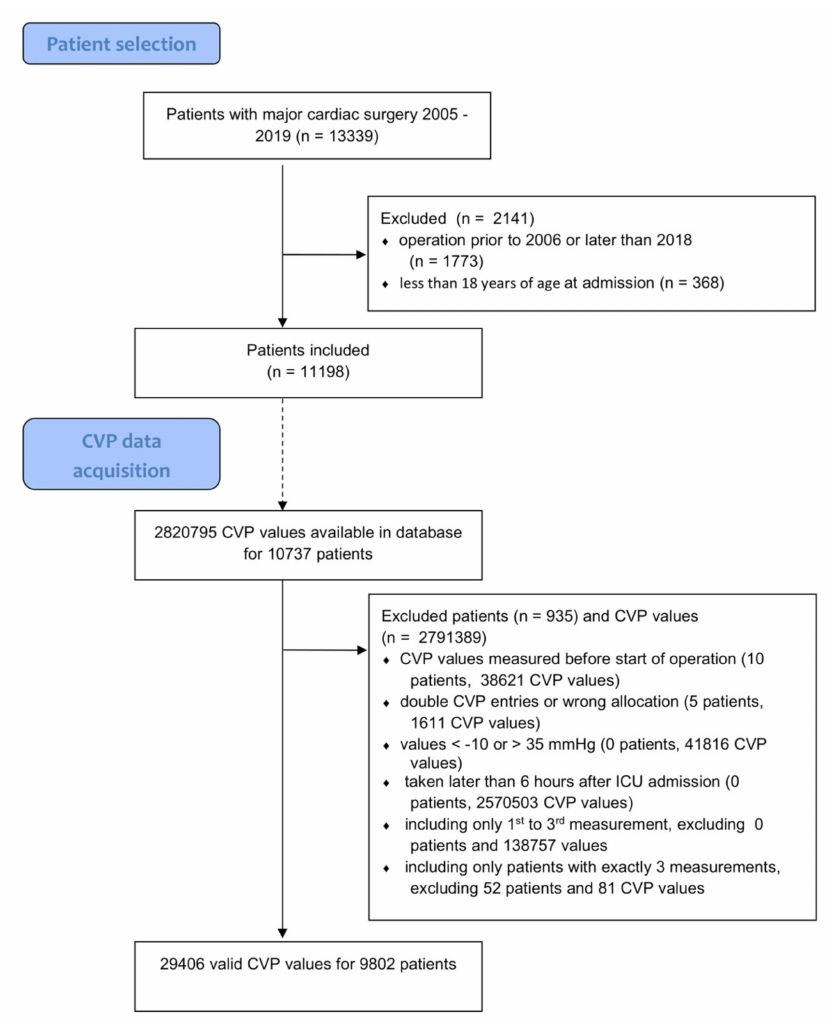
Figure 1. Flow Diagram. CVP = central venous pressure; ICU = intensive care